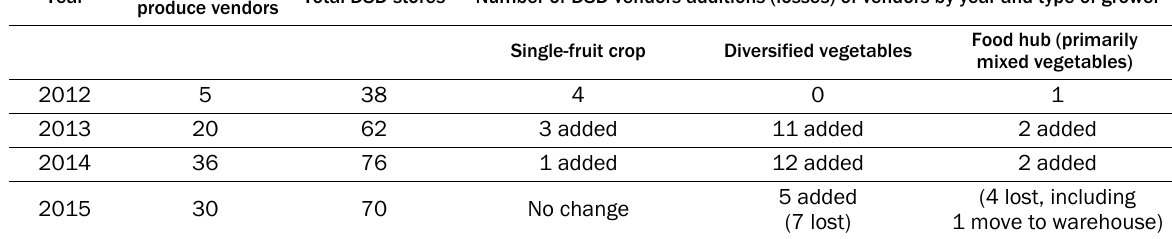
Table 1. Type and Number of Direct-Store-Delivery (DSD) Produce Vendors and Stores, Focal Grocery Store Chain,